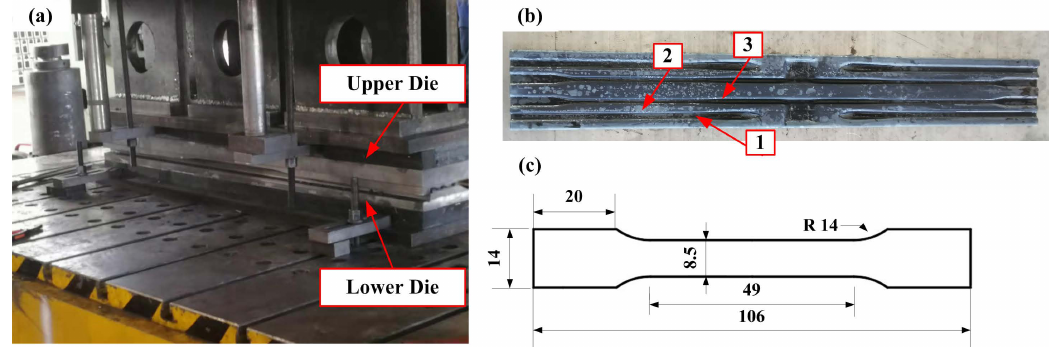
Figure 10. Hot stamping dies, ( a ) the locations, and ( b ) geometry of the tensile specimens ( c ) (unit: mm).